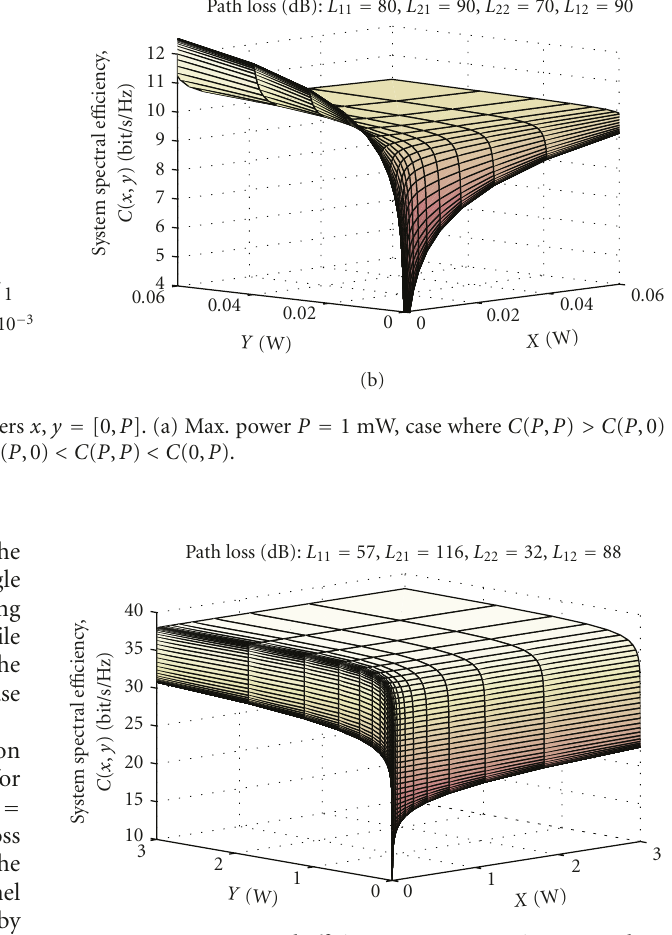
power, gains tend to be marginal for simultaneous transmis- sion. The reason is that the increase of transmit power on the intended link in turn increases the interference on the other link. This is particularly true in case the system spectral e ffi ciency C ( P , P ) is dominated by mutual